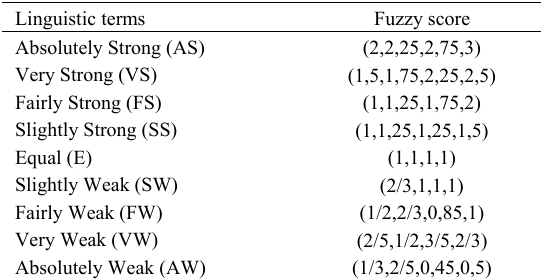
Table 1. Fuzzy evaluation scores for the weight vector.